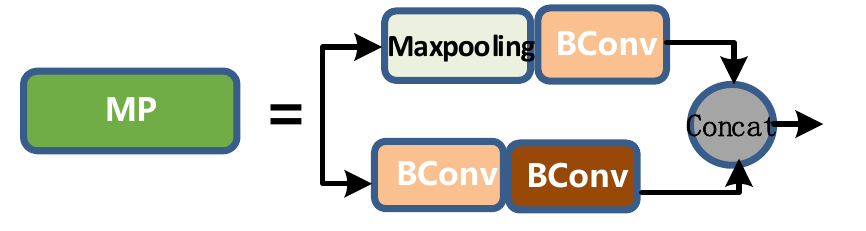
Figure 9. MP layer diagram. Figure 9. MP layer